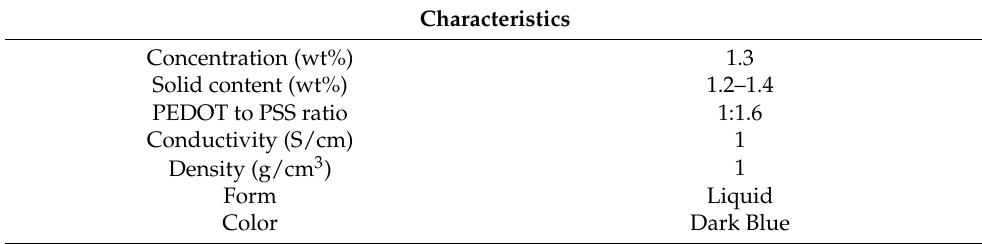
Table 2. Specifications of the poly(3,4-ethylenedioxythiophene):poly(styrenesulfonate).